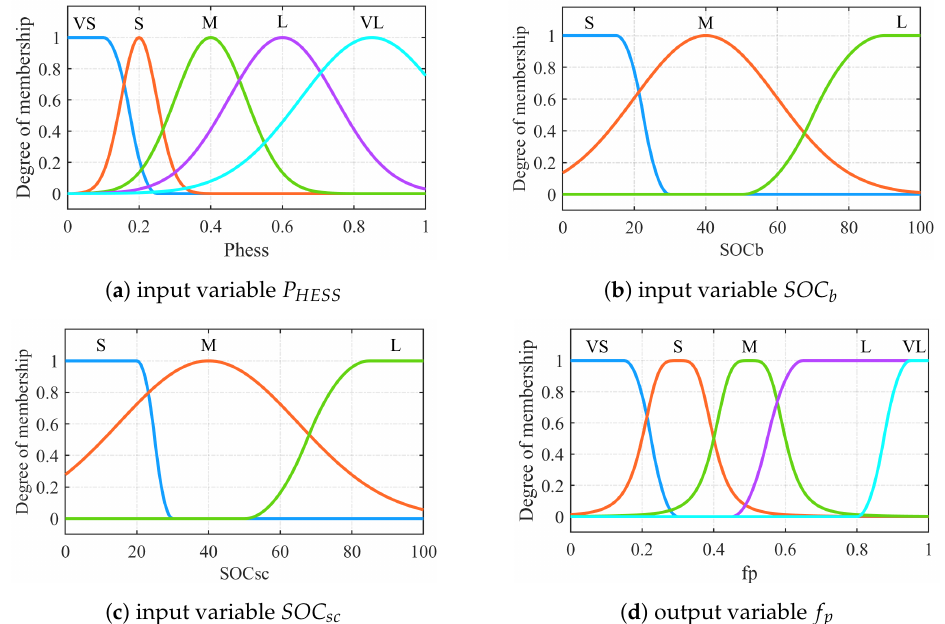
Figure 10. Membership functions of input and output variables in FLC. Table 5. Fuzzy logic control